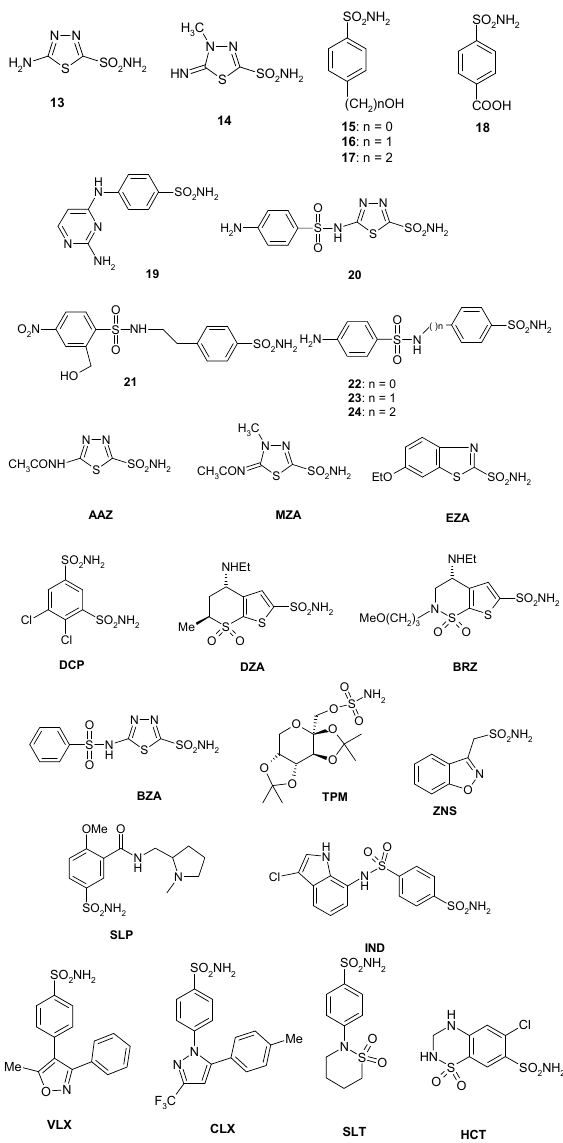
Figure 1. Structure of sulfonamides/sulfamates investigated in the present study. AAZ: acetazolamide; BRZ: brinzolamide; BZA: benzolamide; CLX: celecoxib; DCP: dichlorophenamide; DZA: dorzolamide; EZA: ethoxzolamide; HCT: hydrochlorothiazide; IND: indisulam; MZA: methazolamide; SLP: sulpiride; SLT: sulthiame; TPM: topiramate; VLX: valdecoxib; ZNS: zonisamide.